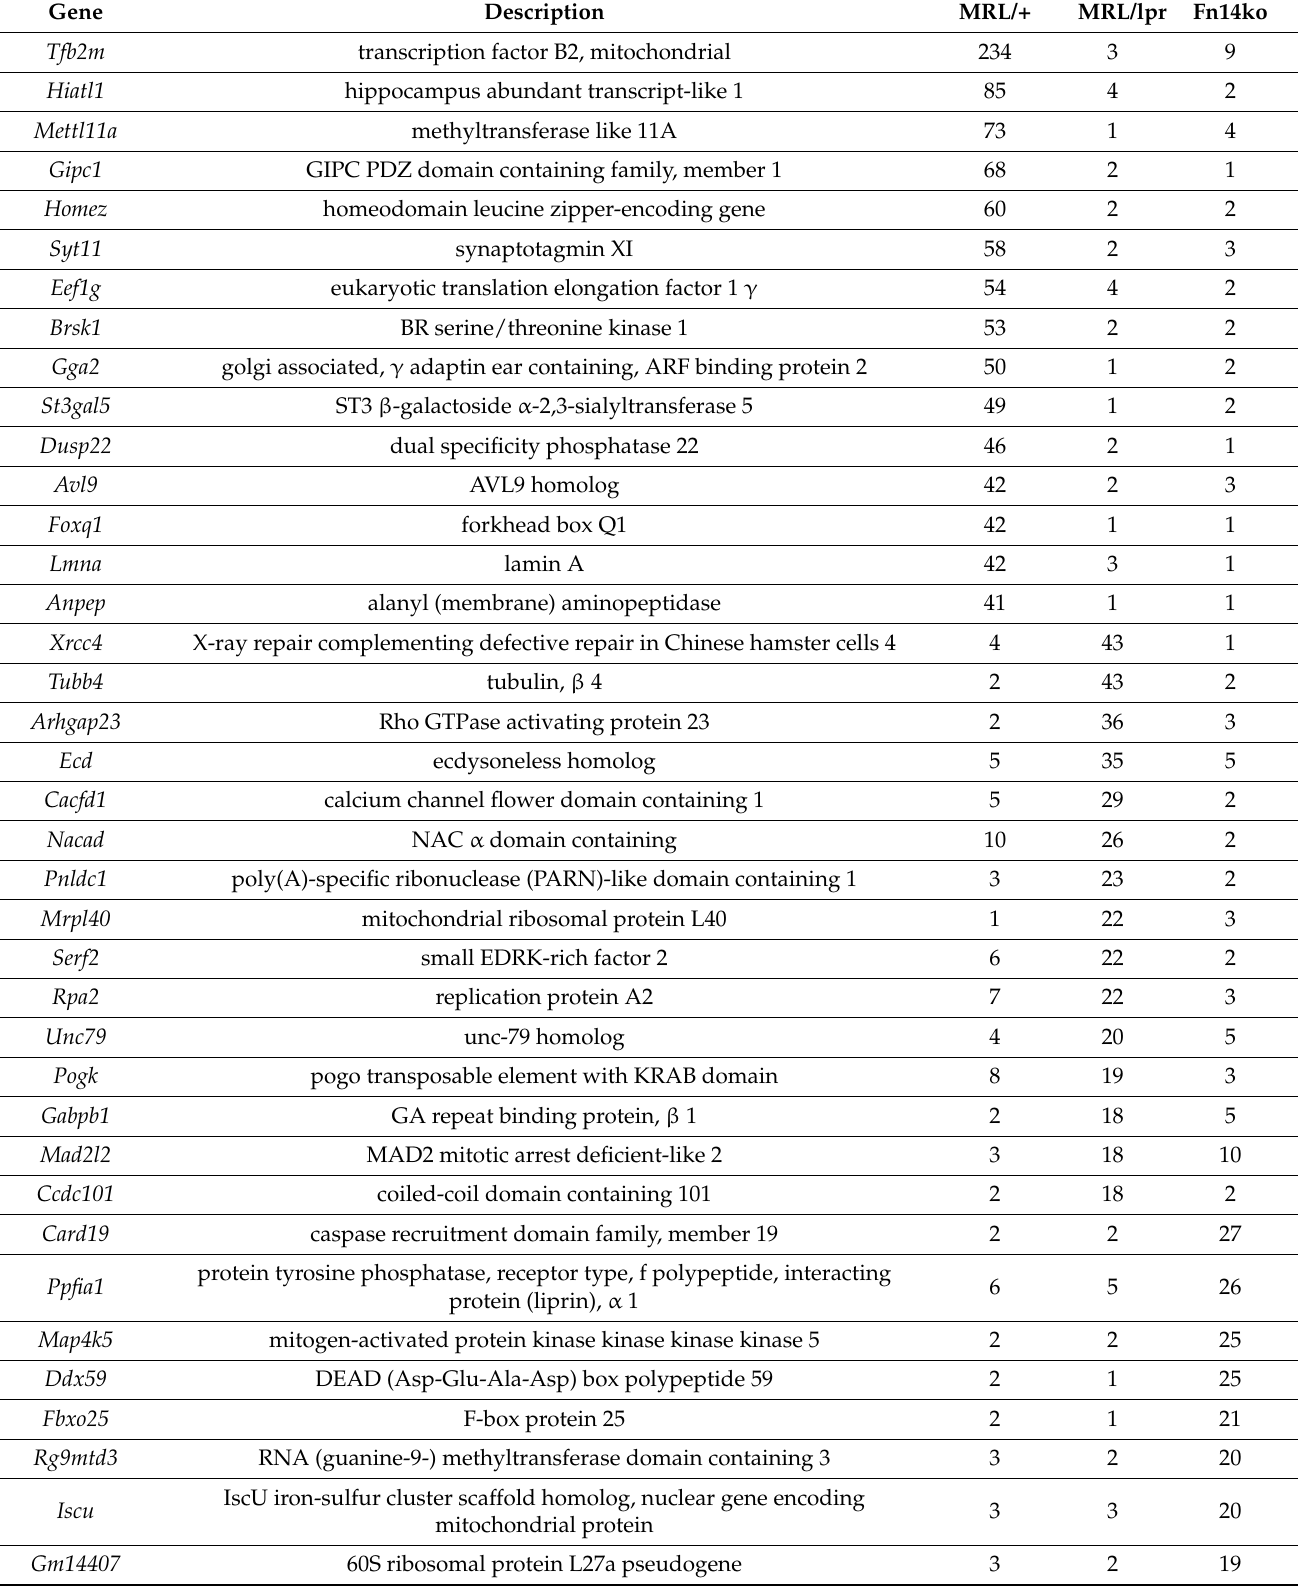
Table 3. The top 15 genes in each phenotype. The numbers are the gene commanding heights (GCH) in the indicated phenotypes. Top genes have the highest